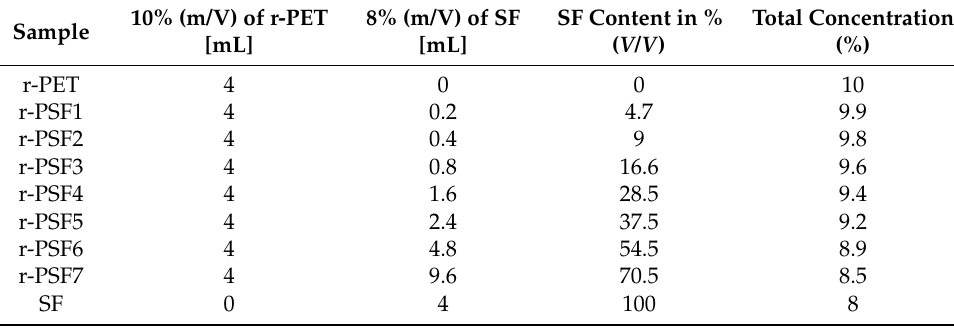
Table 1. Content of solutions prepared for